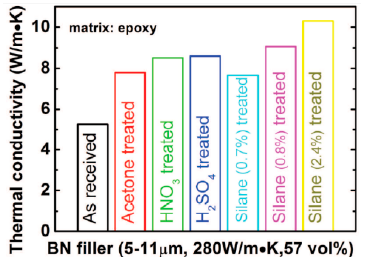
Figure 41. Effect of various surface treatments on the thermal conductivity of epoxy/BN composites (© 2016 IEEE. Reprinted, with permission, from [59]).